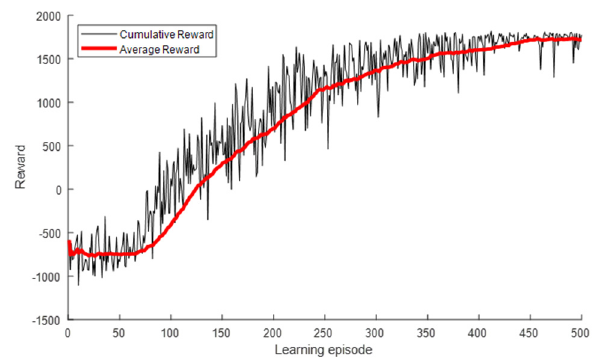
Figure 13. ( a ) 𝐼𝑁𝑅 and ( b ) 𝑝 (cid:3042)(cid:3048)(cid:3047) for each learning episode for interfered receiver ② .